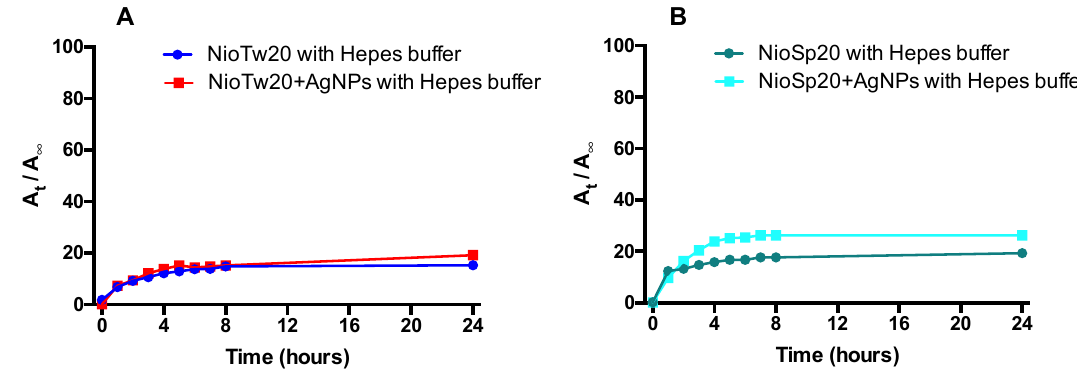
Figure 6. Calcein release studies in HEPES buffer at 37 °C from: ( A ) NioTw20/AgNPs; ( B ) NioSp20/AgNPs.